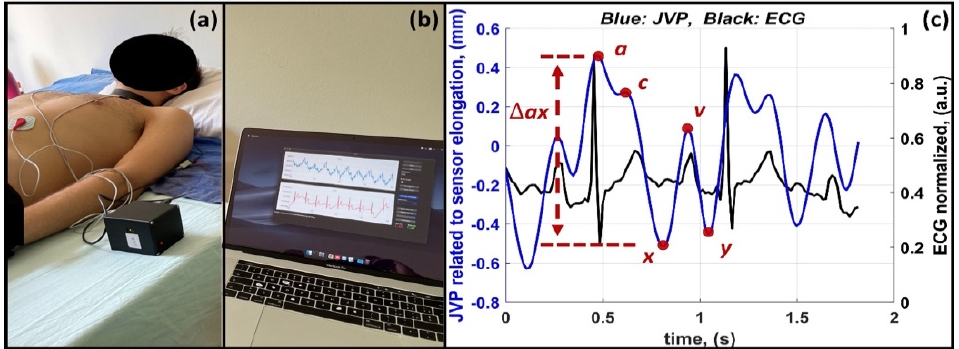
Figure 3. Synchronized acquisition of JVP and ECG signals. A subject lying on a bed ( a ); real-time data visualization ( b ); post-processed JVP and ECG signals ( c ).